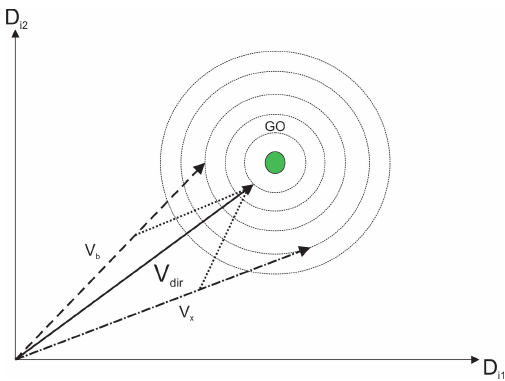
Figure 3. Global optima with V x and V b .